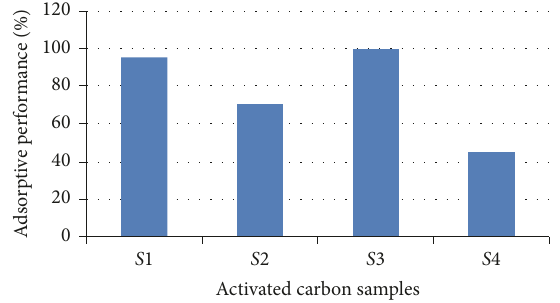
Figure 2: Adsorptive performance for activated carbon. Table 2: Effect of activating agent on adsorptive performance.